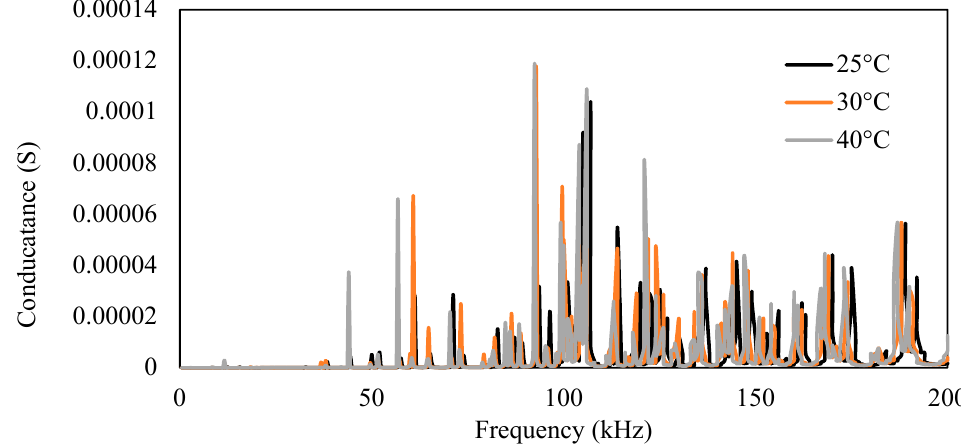
Figure 15. Conductance signature plot varying all the properties at different temperatures (of PZT patch + aluminum beam).